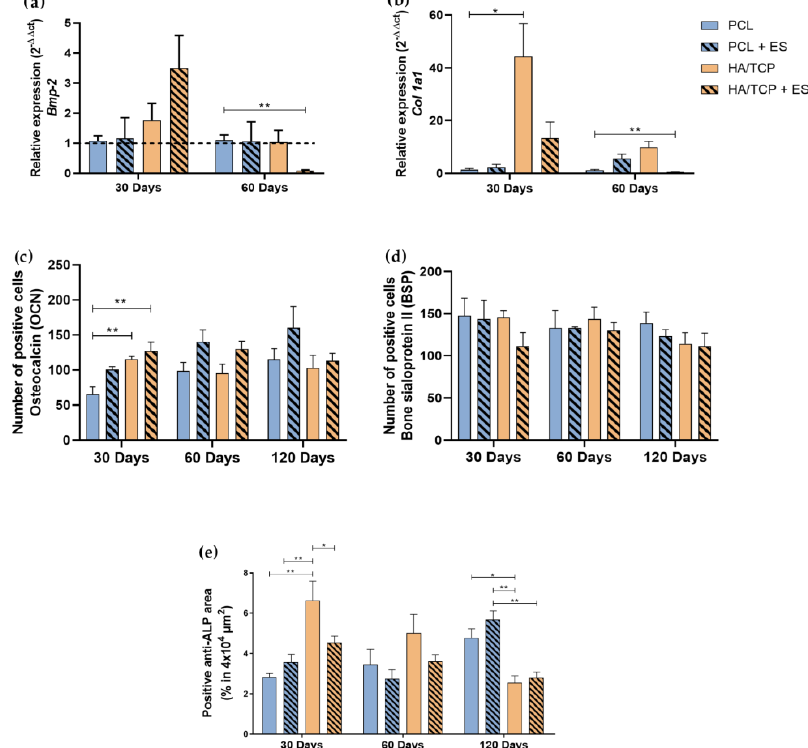
Figure 4. Relative expression of ( a ) Bmp-2 , ( b ) Col1a1 (2 − ∆∆ ct ). Evaluation of BSPII, OCN and ALP by immunohistochemistry in 4 × 10 4 µ m 2 area of images: ( c ) Quantification of anti-OCN positive cells, ( d ) quantification of anti-BSPII positive cells, ( e ) quantification of anti-ALP area. Results were expressed as mean ± standard error of the mean (significance levels were established in * p < 0.05, ** p <